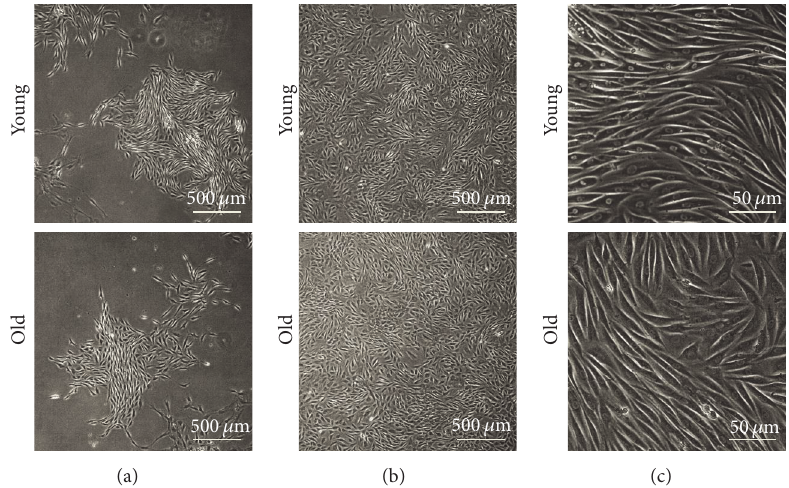
Figure 1: Characterization of NPMSCs growth and morphology ( 𝑛 = 5 ). (a) Larger adherent colonies were observed in young NPMSCs compared to old NPMSCs during primary culture. (b) Young NPMSCs grew more rapidly and reached cell confluence earlier than old NPMSCs after primary isolation. (c) Both young and old NPMSCs at P3 had a small and spindle-shape morphology, with no substantial differences between